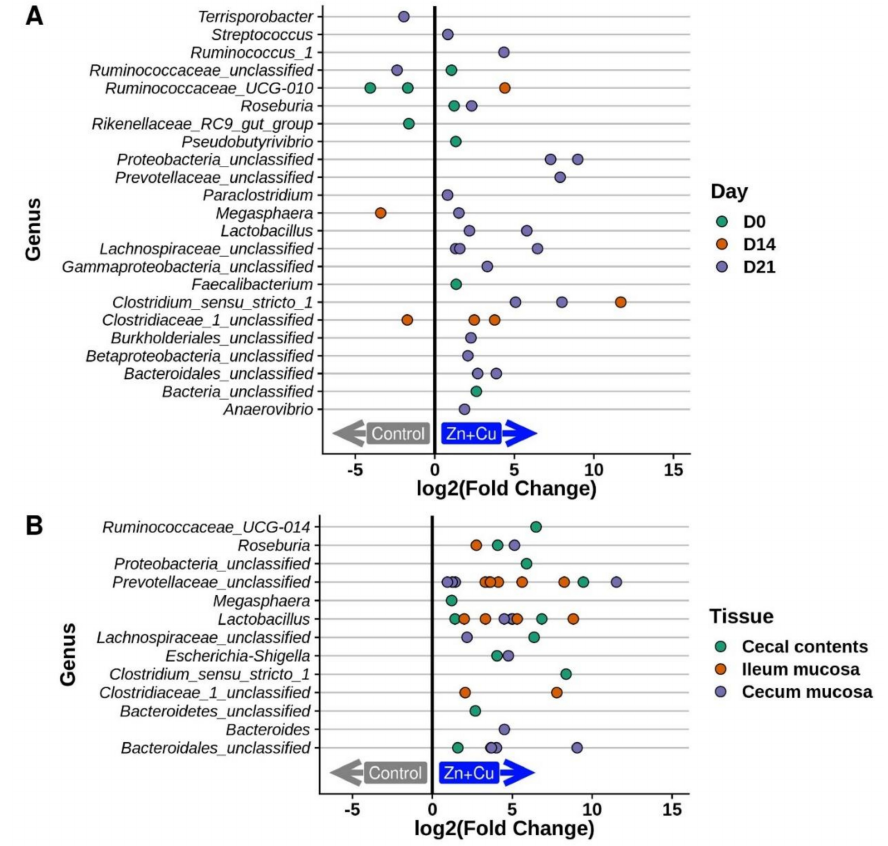
Figure 4. Di ff erentially abundant operational taxonomic units (OTUs) from 16S rRNA gene-based fecal communities analysis. Tests compared control communities to Zn + Cu communities within each combination of timepoint ( A ) and tissue ( B ) independently. Each point represents one OTU, di ff erent OTUs from the same genus are displayed on the same line. Positive log2(FoldChange) value indicates enrichment in the “Zn + Cu” treatment group and a negative log2(FoldChange) value indicates enrichment in the “control” group. OTUs are classified according to the SILVA v132 taxonomy. Di ff erential abundance was determined with DESeq2. Only OTUs with log2(FoldChange) > 0.75 and FDR p < 0.05 are